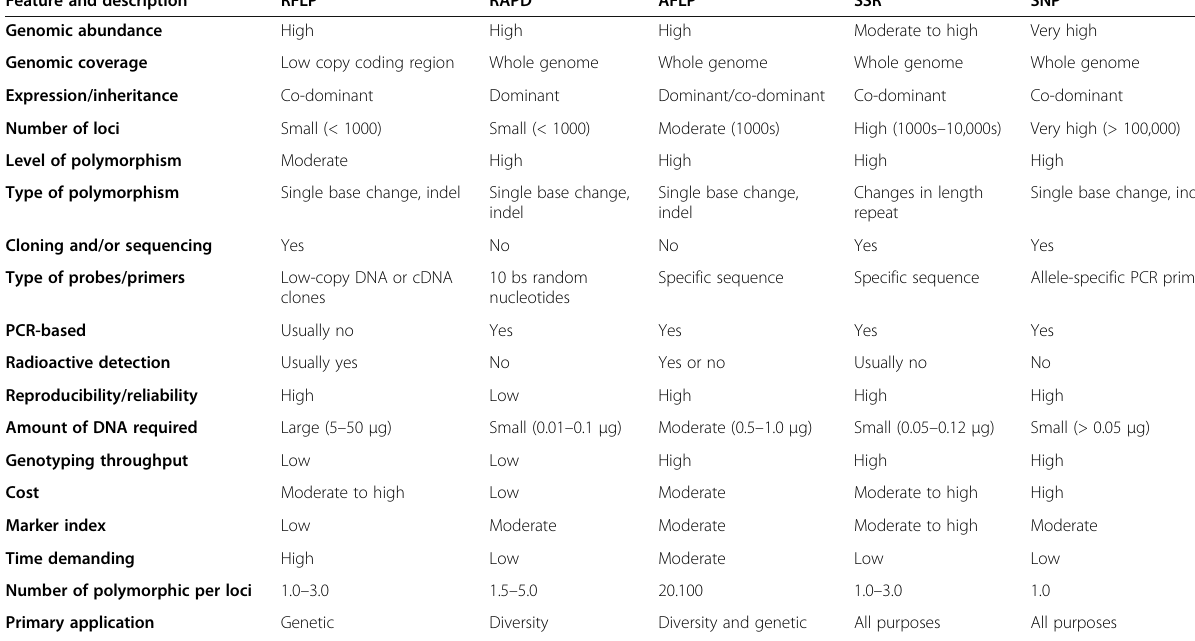
Table 1 Comparison of most widely used DNA marker system in plants Feature and